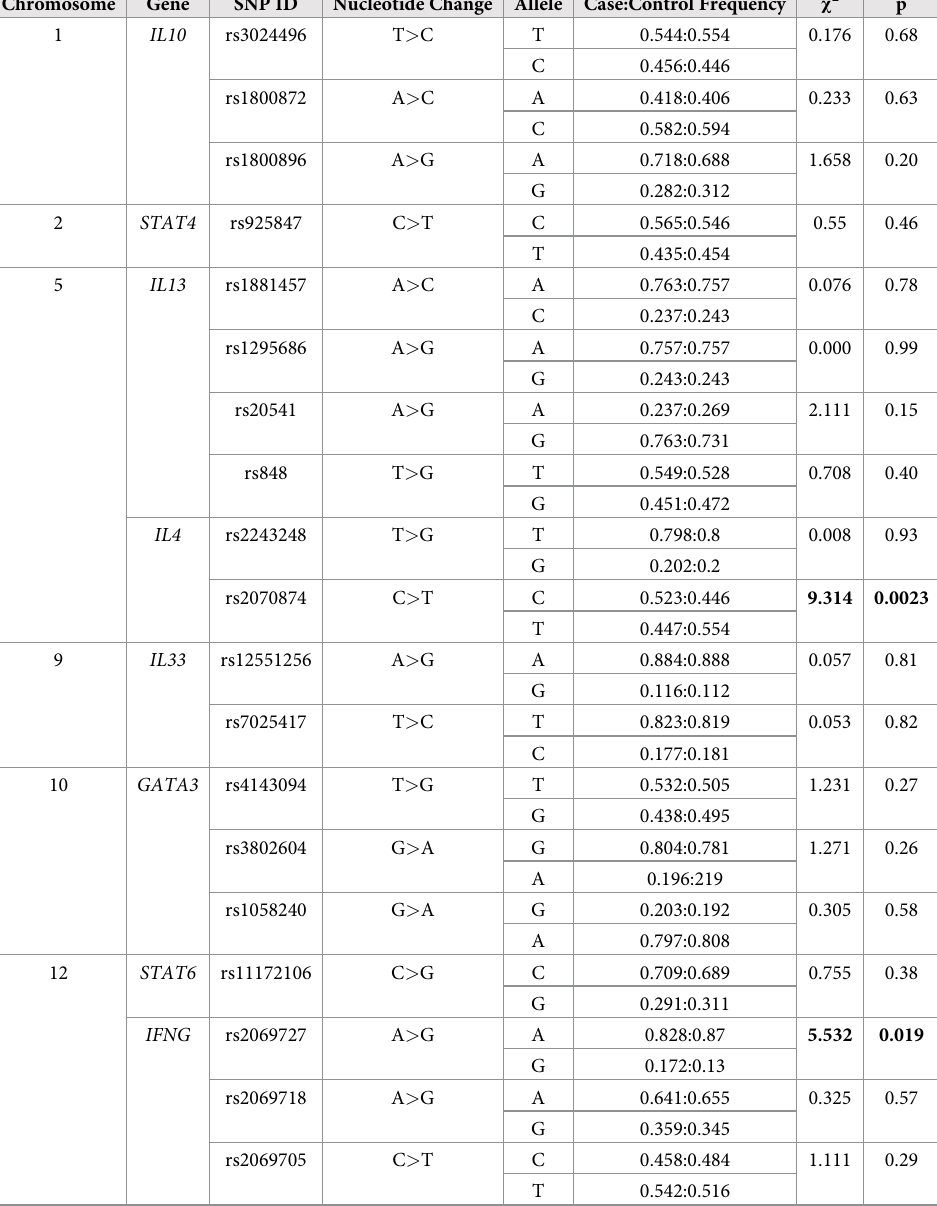
Table 3. Case-control analysis of SNP MAFs between schistosome-infected (N = 354) and–uninfected individuals (N =